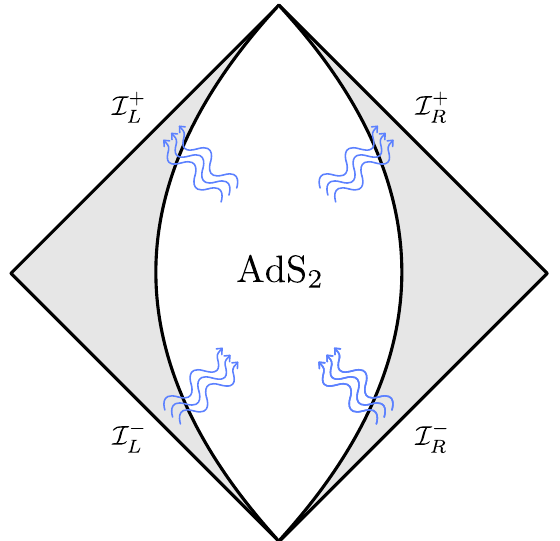
Figure 1: The geometric setup for the S -matrix. The shaded regions are the asymp- totically flat regions with vanishing electric field. On their asymptotic boundaries I ± , we define Hilbert spaces H ± . The region in the middle is an AdS R / L R / L constant electric field and flux (blue) is allowed through its